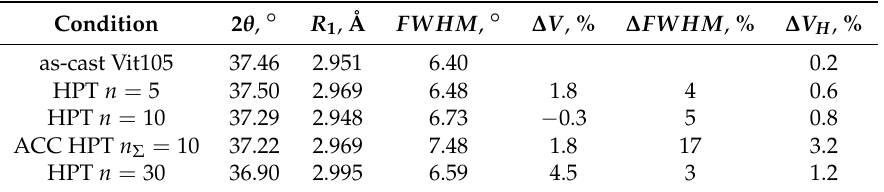
Figure 2. XRD results for the Vit105 BMG: as-cast; after HPT for n = 5, n = 10, n = 30; after accumulative HPT for n Σ = 10: ( a ) overview; ( b ) enlarged halo area, the arrow indicates the position of the halo gravity center. Table 1. XRD data on the structure of Vit105 in various conditions: BMG Vit105 after HPT via different regimes and accumulative HPT for n Σ =